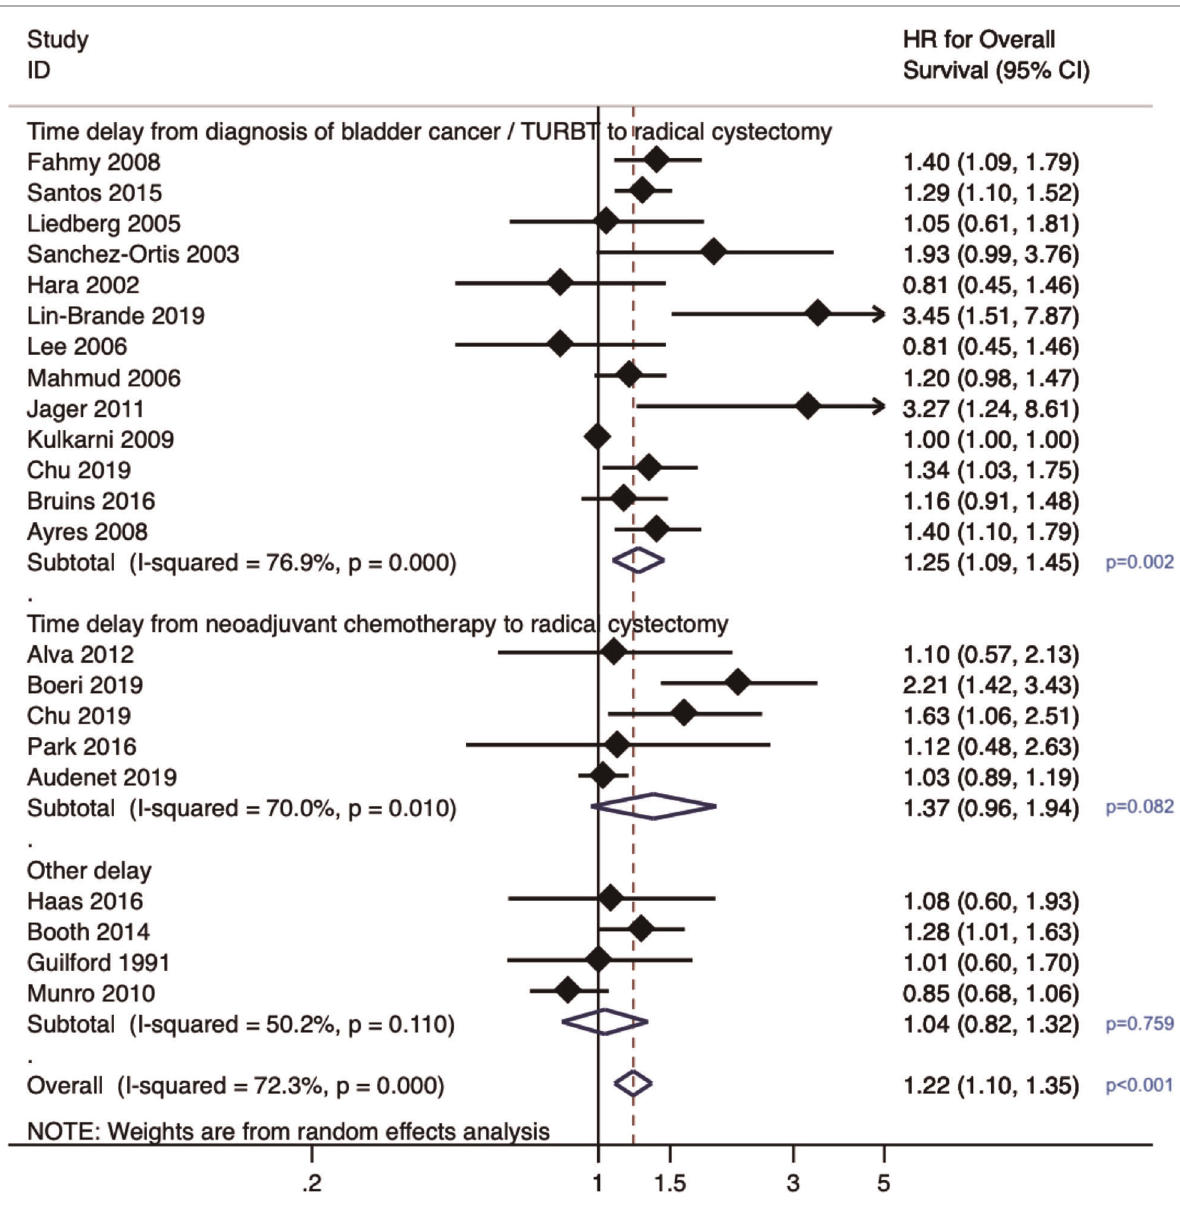
FIGURE 2 Forrest plot for meta-analysis on effect of delayed radical cystectomy on overall survival in bladder